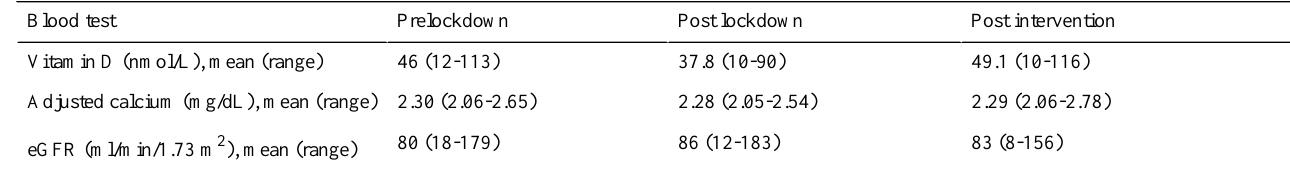
Table 3. Average vitamin D, adjusted calcium, and estimated glomerular filtration rate (eGFR) serum